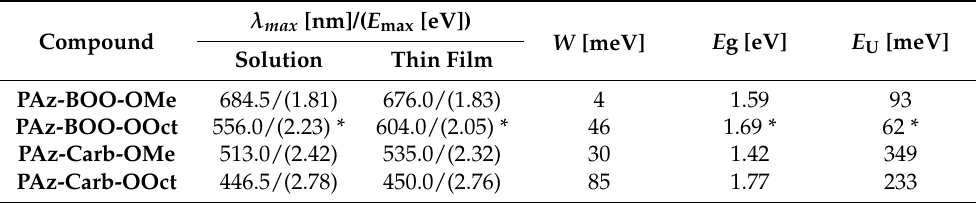
Table 5. Positions of absorption bands connected with π → π * transitions of imine solutions and thin films, together with exciton band widths and absorption edge parameters of thin films. λ max [nm]/( E max [eV]) Compound W [meV] E g [eV] E U [meV] Solution Thin Film PAz-BOO-OMe 684.5/(1.81) 676.0/(1.83) 4 1.59 93 PAz-BOO-OOct 556.0/(2.23) * 604.0/(2.05) * 1.69 * 62 * PAz-Carb-OMe PAz-Carb-OOct